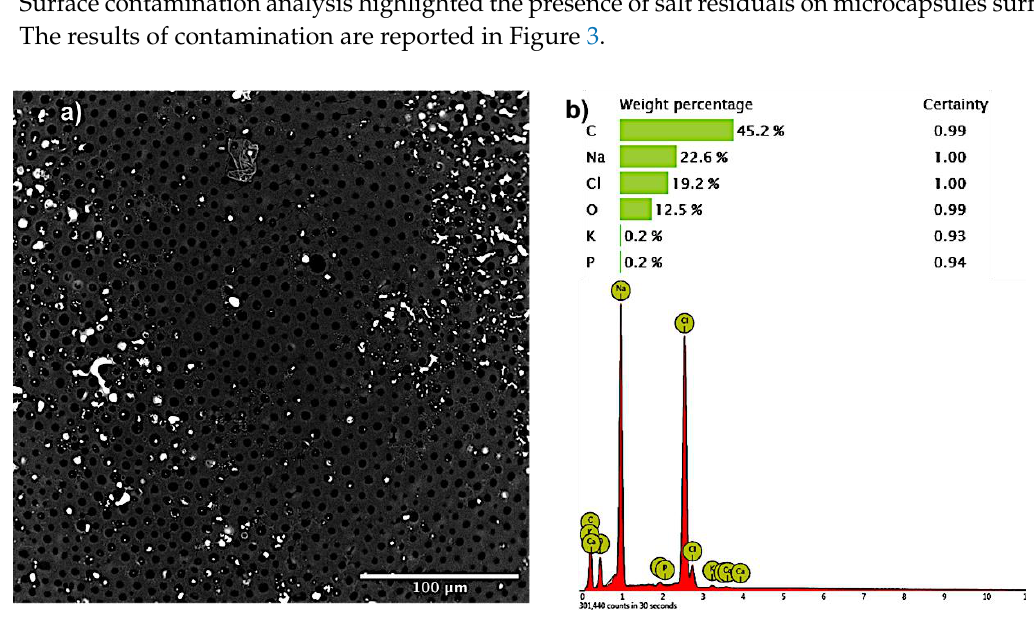
Figure 3. Microelements surface analysis performed by X-ray analysis. ( a ) microcapsule SEM image; (b) element composition expressed in weight percentage.